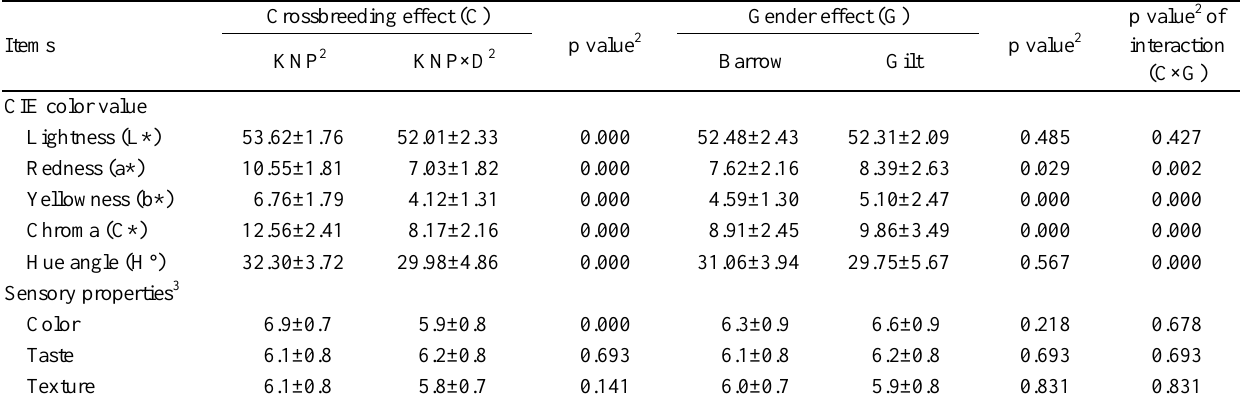
Table 3. Commission Internationale de I’Eclairage (CIE) color values and sensory properties 1 of Musculus longissimus dorsi of Korean Native Black Pig and its crossbred with Duroc pig